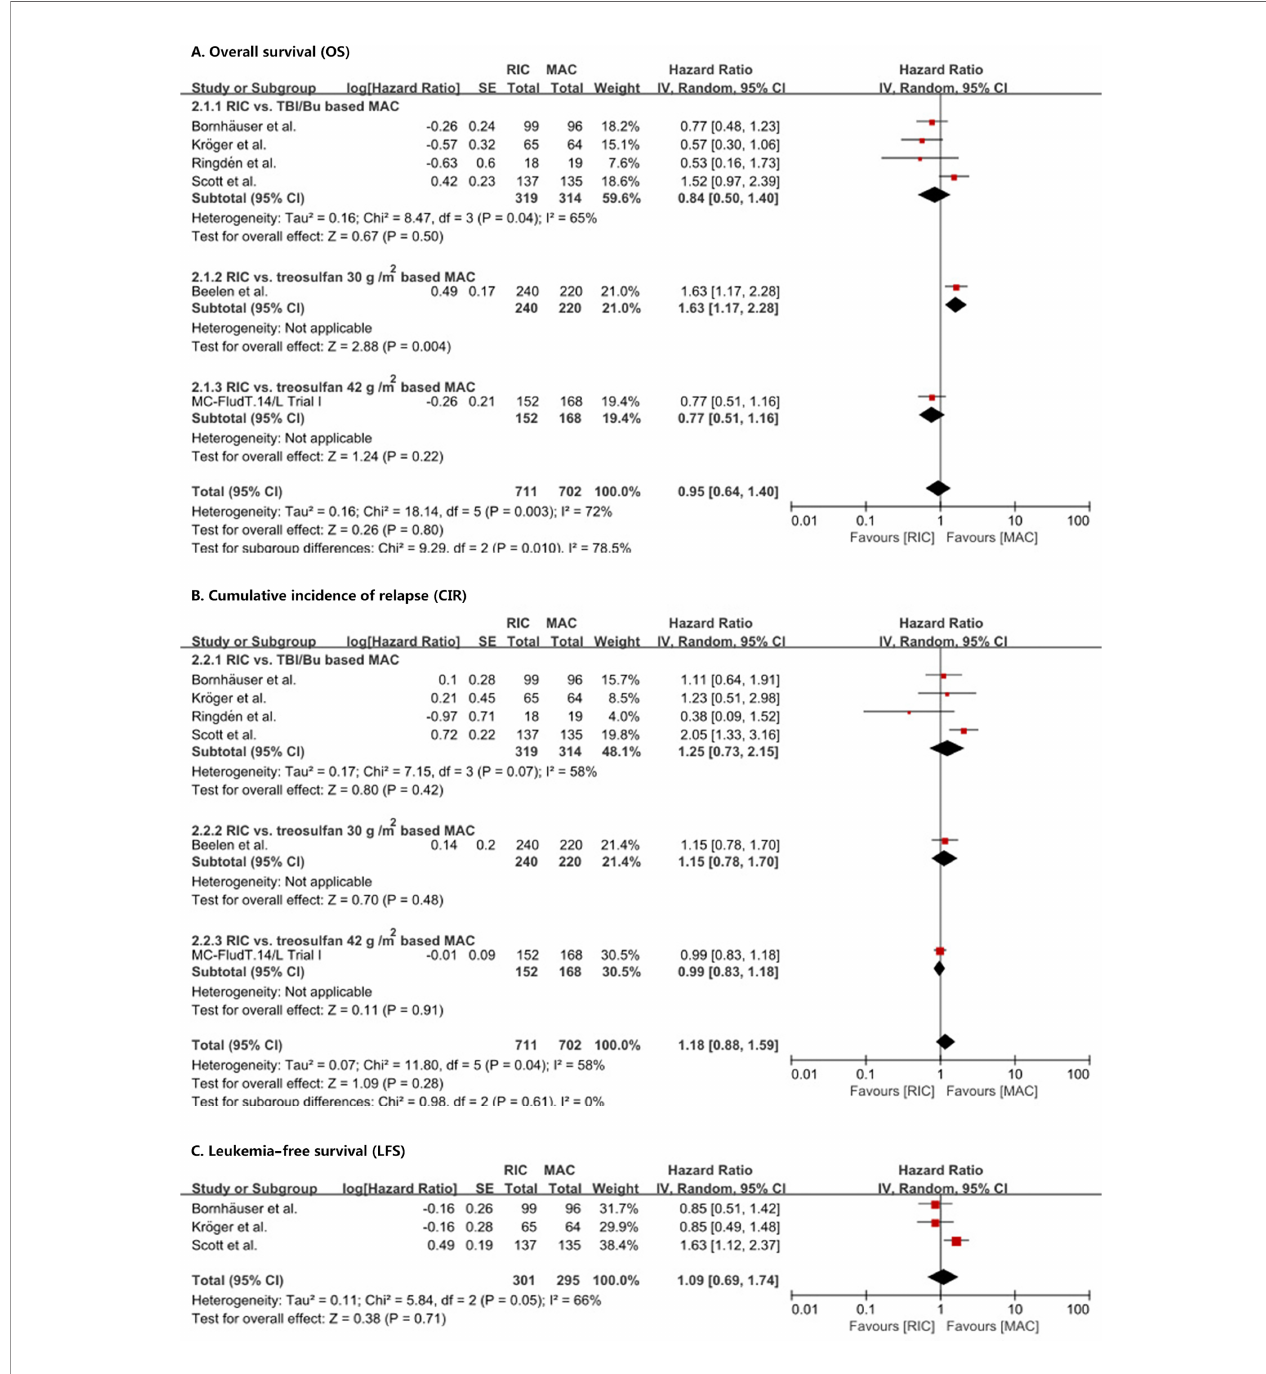
FIGURE 2 | Results of meta-analyses of OS, CIR, and LFS endpoints. The forest plots showed that RIC had the same OS (A) , CIR (B) , and LFS (C) as MAC. RIC, reduced intensity conditioning; MAC, myeloablative conditioning; TBI, total body irradiation; Bu,